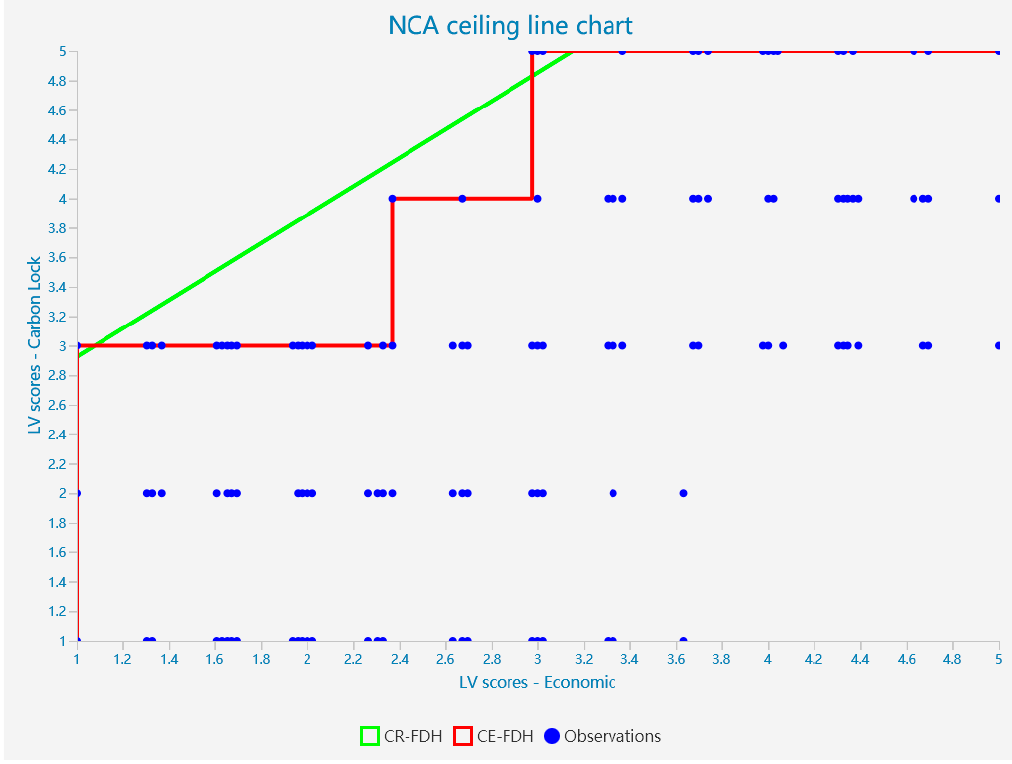
Figure 6. Scatterplot of the analysis of the necessity of economic factors for carbon unlocking.